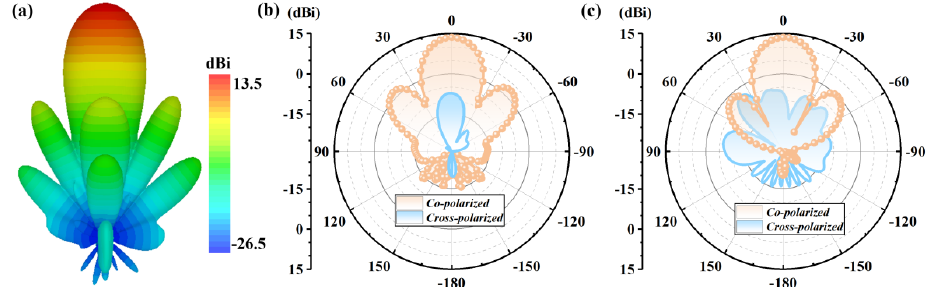
Figure 5. Simulated radiation patterns for the CFMS at 3.98 GHz. ( a ) 3D radiation patterns of the CFMS at 3.98 GHz. ( b ) Radiation patterns of co- and cross-polarized components in the xoz-plane for the CFMS. ( c ) Radiation patterns of co- and cross-polarized components in the yoz-plane for the